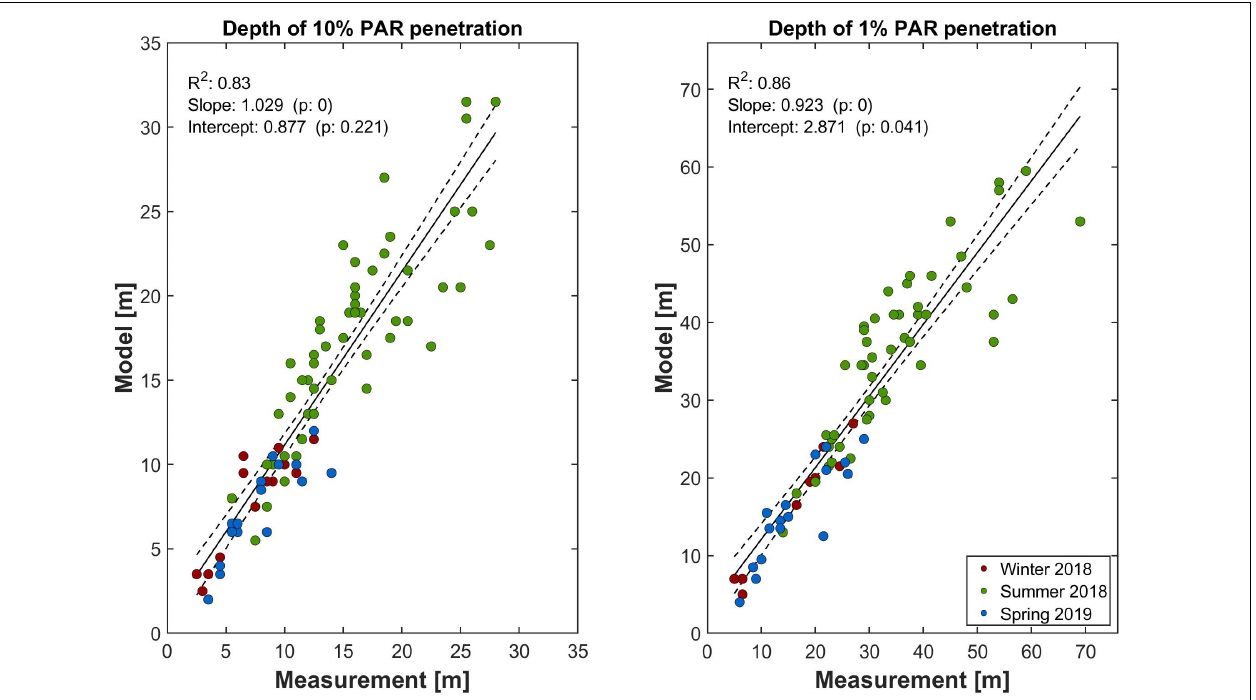
FIGURE 8 | Comparison of penetration depths from PAR derived from in situ and modeled profiles (trimodal approach). The solid line represents the linear fit, while the dashed lines give its 95% confidence